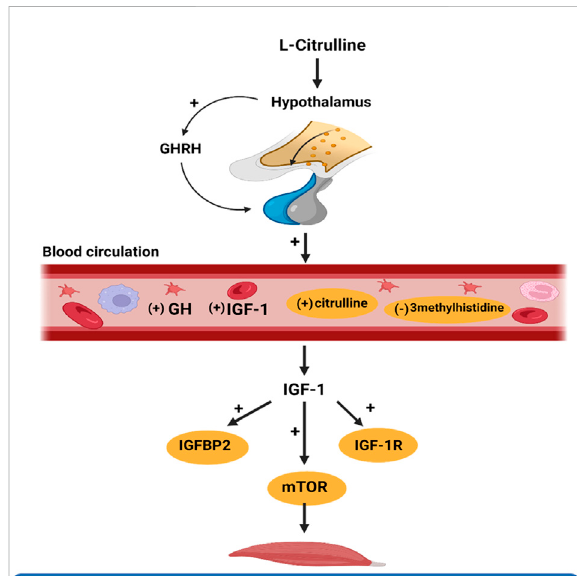
FIGURE 5 Schematicillustration ofthestimulatoryeffectsof L -Citrulline on the GH/IGF-1 axis. The GH/IGF-1 axis is important in regulating body growth. In this study, it was found that with L -Citrulline supplementation, there was a stimulatory release of GHRH from the hypothalamus. The GHRH is responsible for GH production and secretion by the somatotrophs in the anterior pituitary gland. The GH released binds to GH receptors and induces IGF-1 production. This was evidenced by the increased